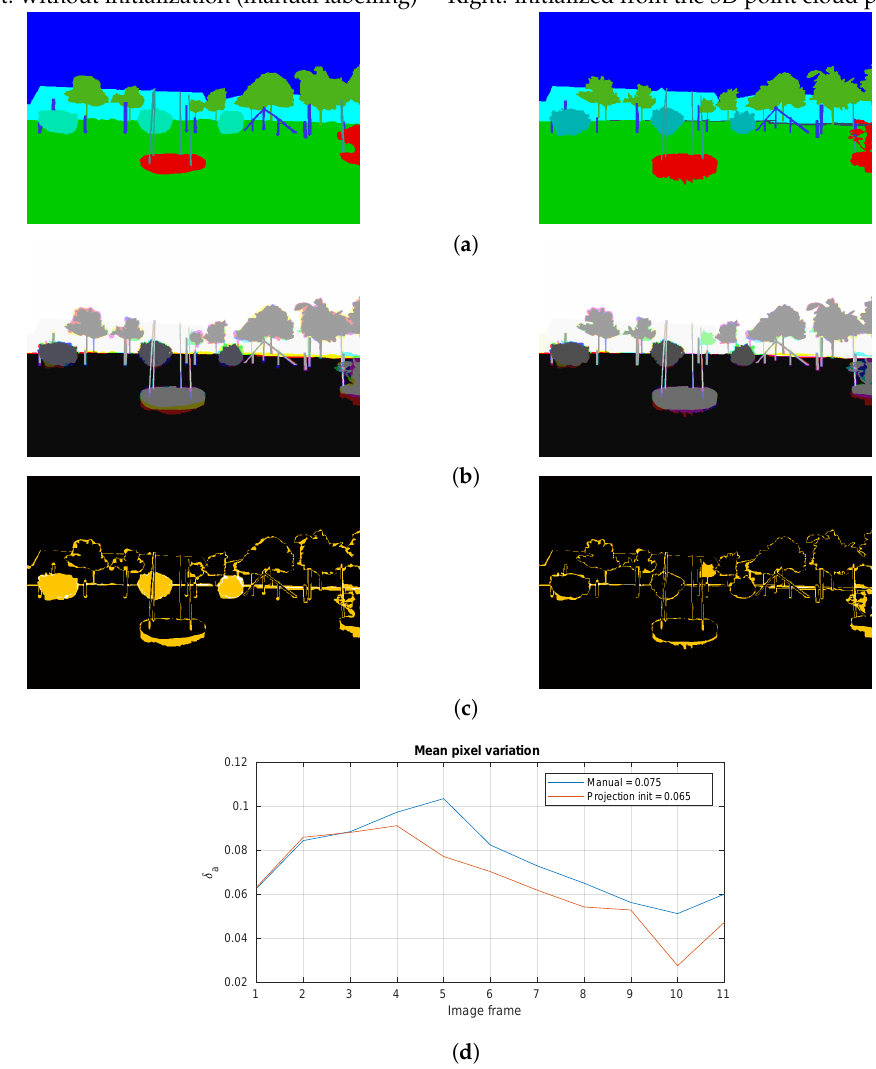
Figure 10. Evaluation of annotation consistency. ( a ) Final single-user annotations A . Observe the differences between two different users and initializations: round topiary bushes get the wrong label (light cyan); round topiary bushes get the correct label (dark cyan). ( b ) Annotations of three users combined as RGB colour channels; grey shades imply a consistent label, colour user variation. (c) Variance of labels from multiple annotators shown with brightness (white = max. δ a ). ( d ) Quantitative comparison of variance in the two different initializations. Results show that the average variance is reduced by 1% pixel-wise when annotation is initialized from the projection, e.g., the round topiary bushes become consistent (yellow discs in ( c ), left, are not present on the